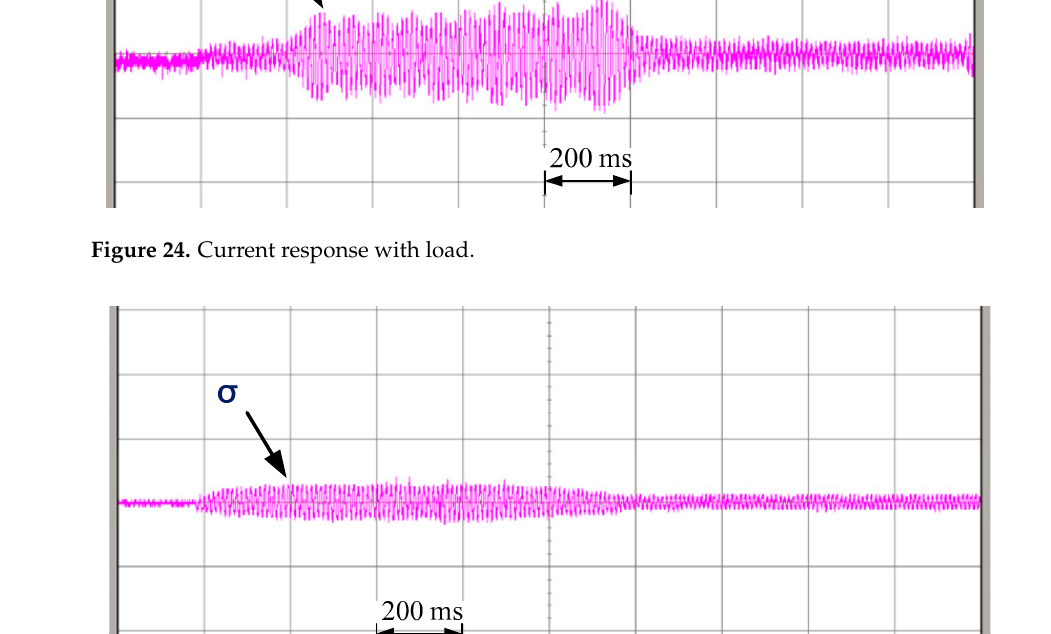
Figure 24. Current response with load. Figure 25. The sliding surface with load. Figure 25. The sliding surface with